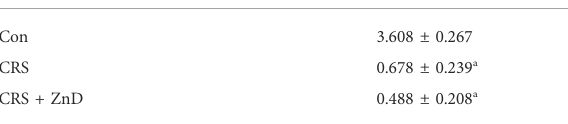
TABLE 2 In fl uences of CRS and CRS + ZnD on mice